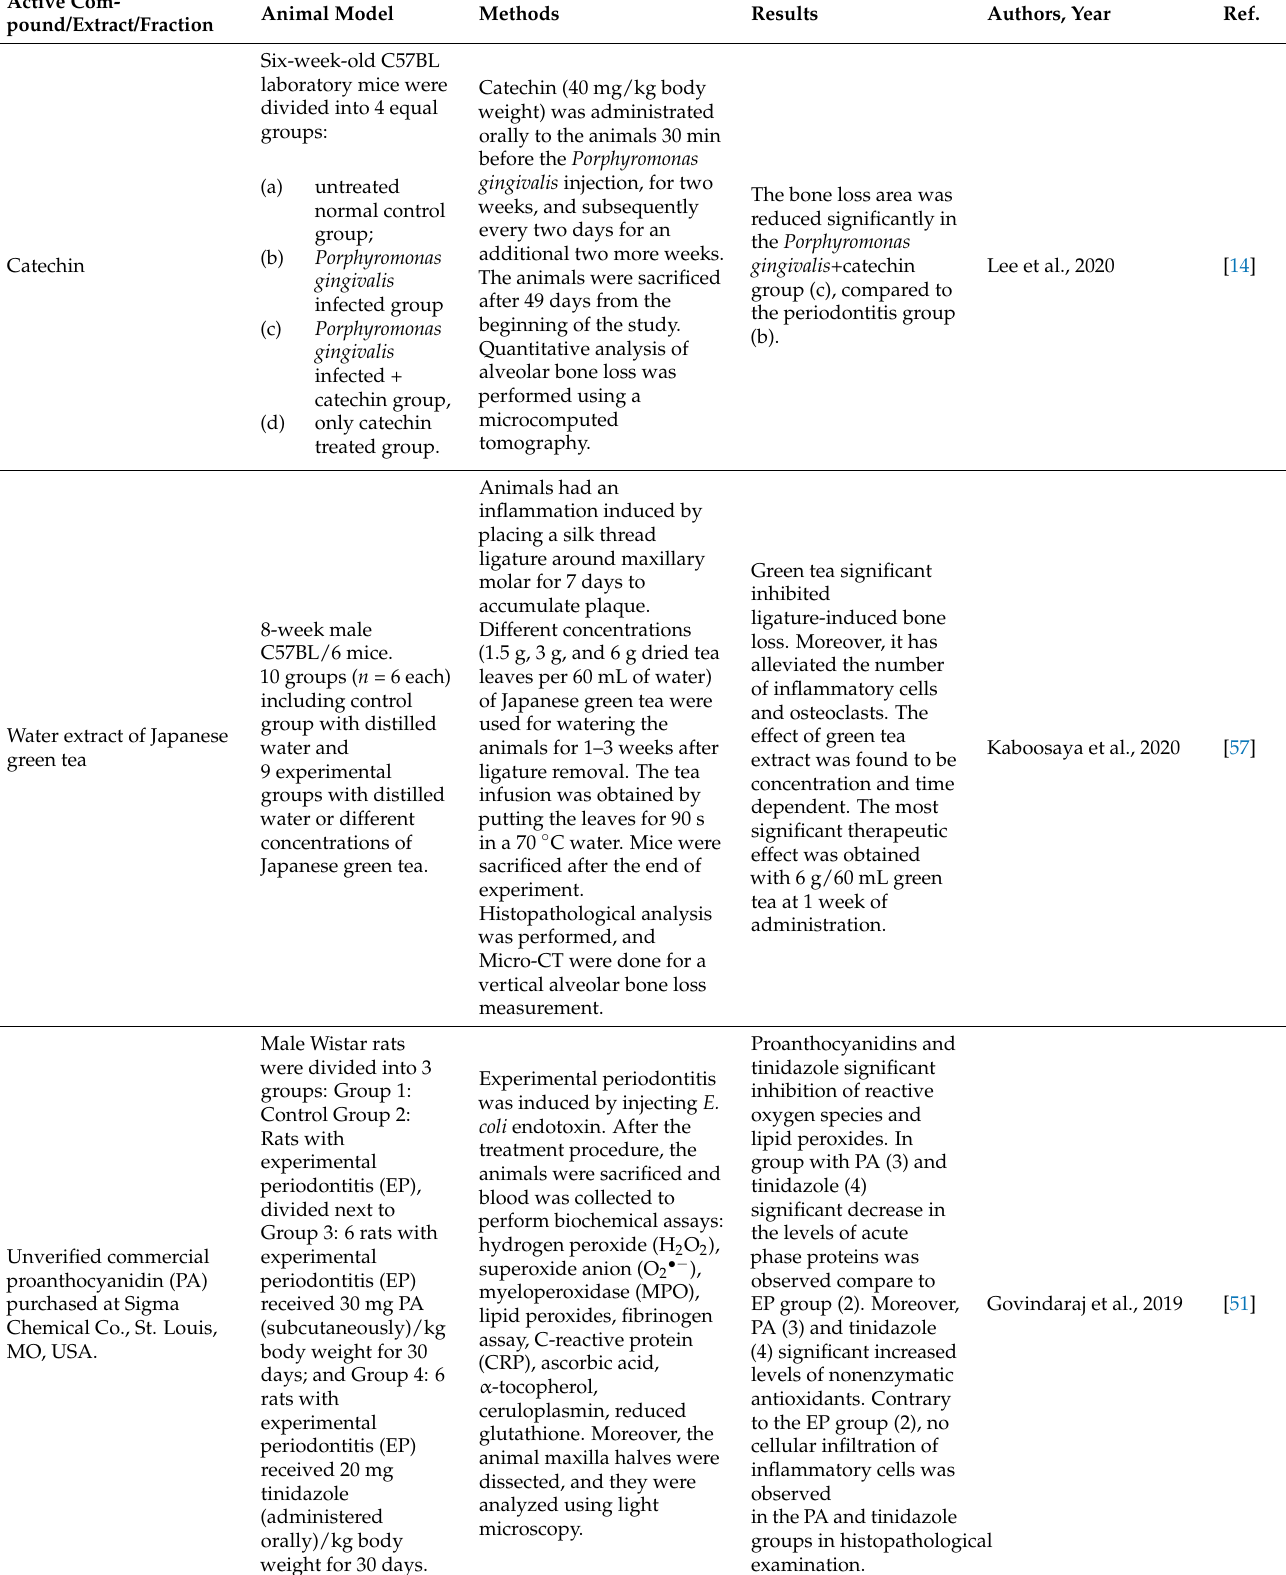
Table 2. In vivo studies reporting influence proanthocyanidins or flavan-3-ols on periodontitis in animal model. Active Com-